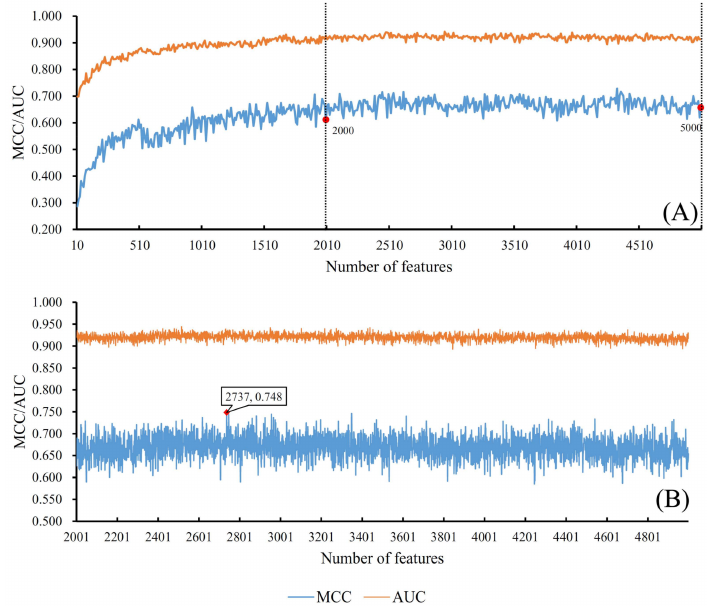
Figure 3. Incremental feature selection (IFS) curves derived from the IFS method and SNN algorithm. X -axis is the number of features participating in building classifiers in feature subsets. Y -axis is their corresponding Matthew’s correlation coefficient (MCC) or area under the curve (AUC) values. ( A ) IFS curve with X-values of 10 to 5000. The selected feature interval for SNN algorithm is [2001, 4999], which were marked with two vertical lines. ( B ) IFS curve with X-values of 2001 to 4999 for SNN algorithm. When first 2737 features in feature list were considered, the optimal MCC value reached 0.748, which is marked by a red